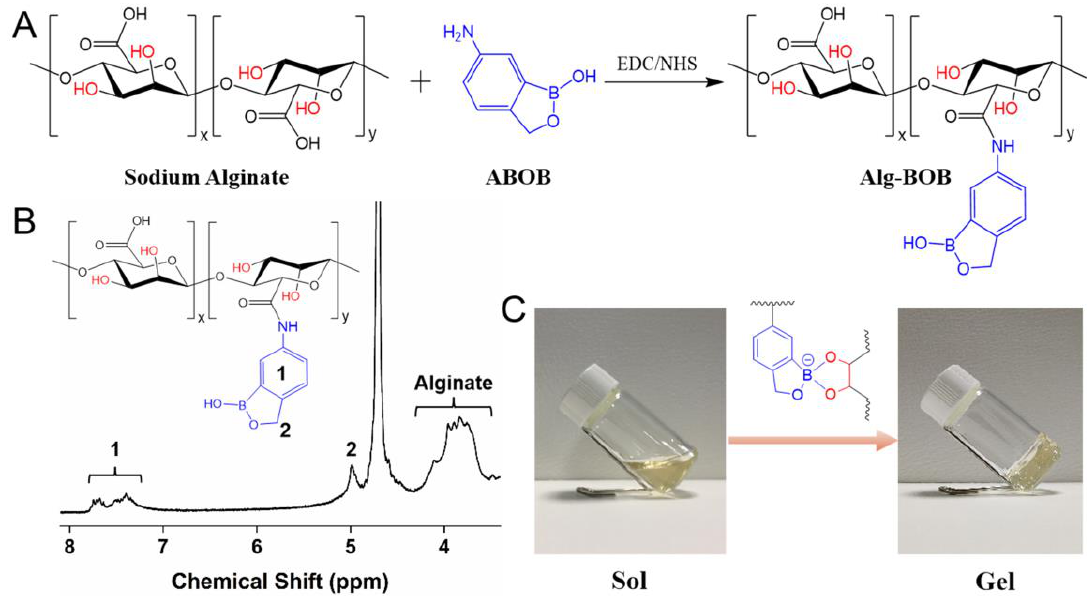
Figure 1. ( A ) Synthetic route of benzoxaborole conjugated alginate (Alg-BOB). ( B ) 1 H NMR spectrum of Alg-BOB. ( C ) The sol-gel transition of Alg-BOB via dynamic crosslinking between BOB and alginate pyranose rings.